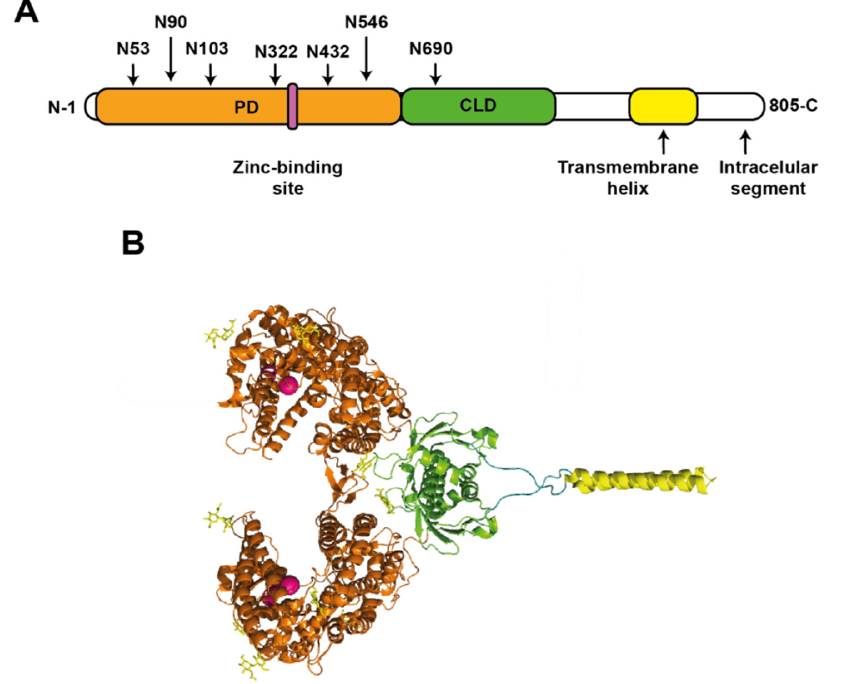
Figure 4. Angiotensin-converting enzyme 2 (ACE2) structure. ( A ) Schematic representation of the ACE2 protein. Peptidase domain (PD) and collectrin-like domain (CLD) are also shown. The N- glycosylation sites are shown as arrows for each amino acid residue, indicating their relative position in PD and CLD. ( B ) Structure of ACE2. According to panel A, the domains and motifs are shown, except the intracellular segment (PDB: 6M17).